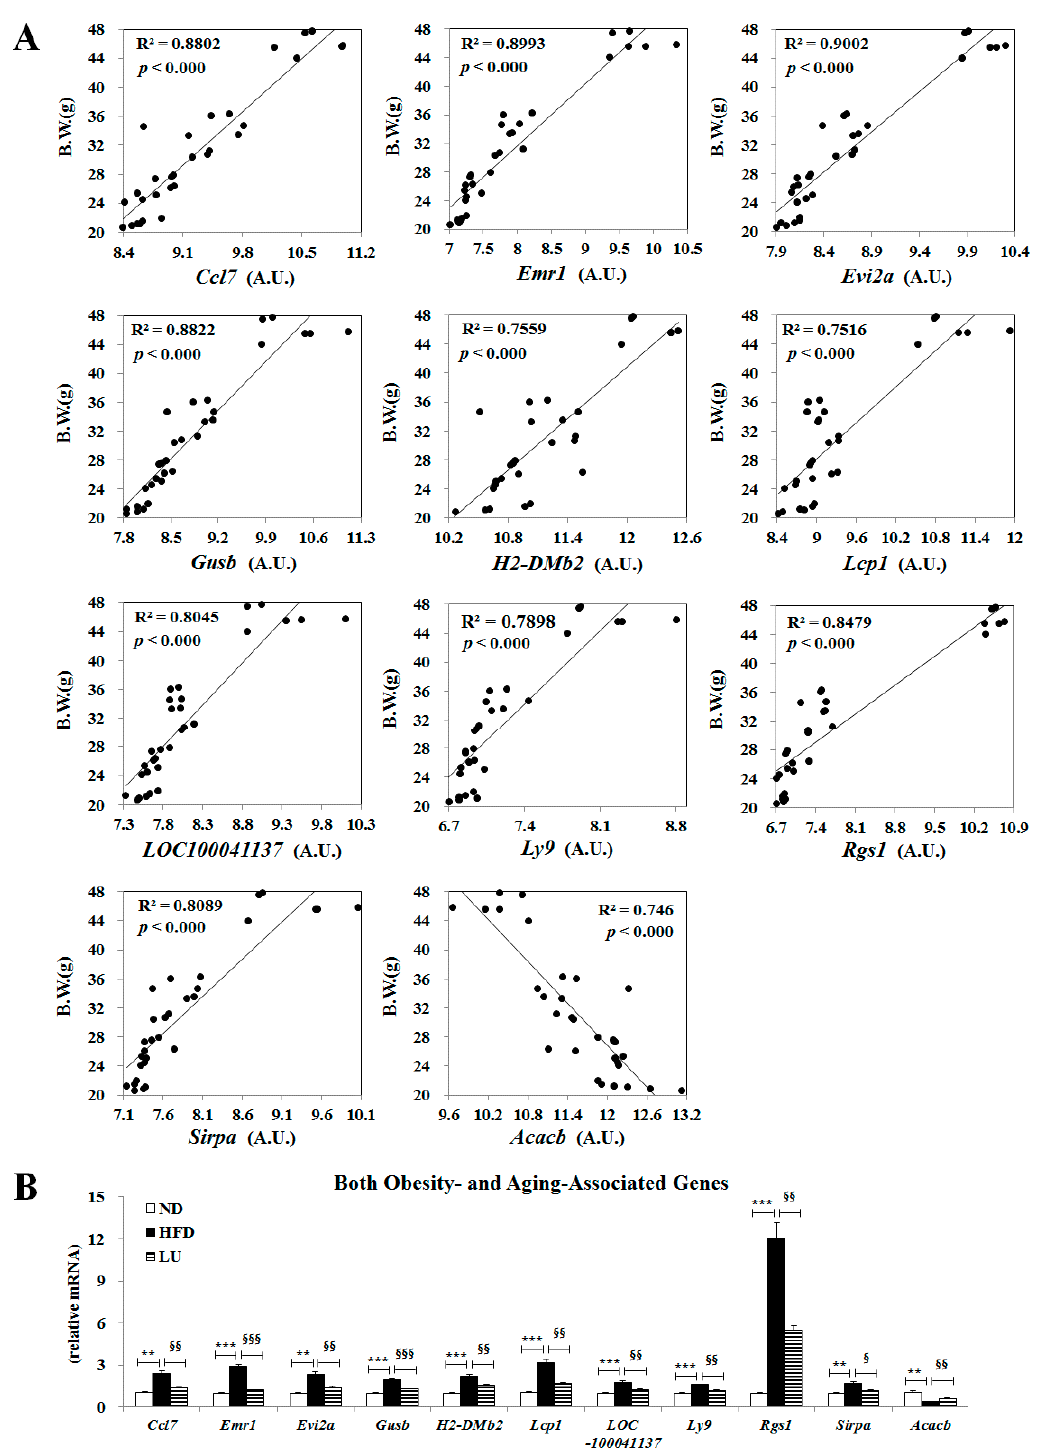
Figure 6. Effect of luteolin treatment for 16 weeks on the expression of genes involved in both obesity and aging. ( A ) Correlation between body weight and genes affected by advancing age ( Ccl7 , Emr1 , Evi2a , Gusb , H2-DMb2 , Lcp1 , LOC10041137 , Ly9 , Rgs1 , Sirpa and Acacb ). ( B ) Expression of obesity- and aging-associated genes. Data are shown as means ± SEM. ND vs HFD: * p < 0.05, ** p < 0.01, *** p < 0.001. HFD vs LU: § p < 0.05, §§ p < 0.01, §§§ p < 0.001.